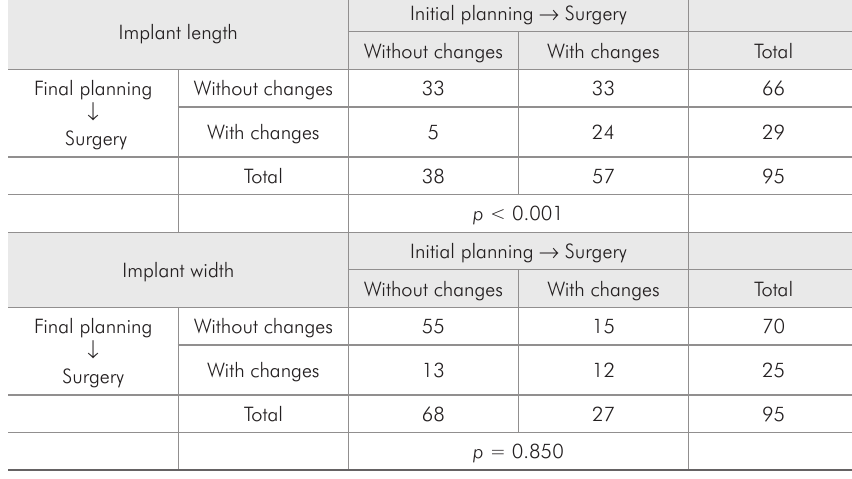
Table 3- Frequency of sites with and without implant length and width changes, in initial and final planning, compared to dimensions of implants inserted at